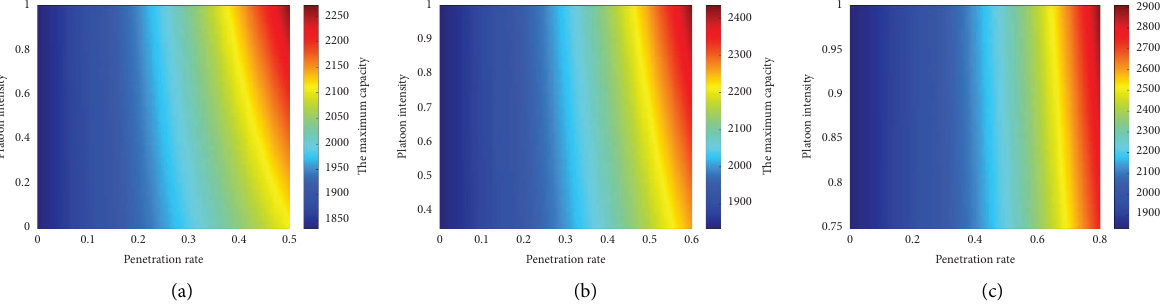
Figure 7: Te heat map of trafc capacity under diferent penetration rates and platoon intensities: (a) p ∈ [ 0 , 0 . 5 ] and E ∈ [ 0 , 1 ] , (b) p ∈ [ 0 , 0 . 6 ] and E ∈ [ 0 . 35 , 1 ] , and (c) p ∈ [ 0 , 0 . 8 ] and E ∈ [ 0 . 75 , 1 ]